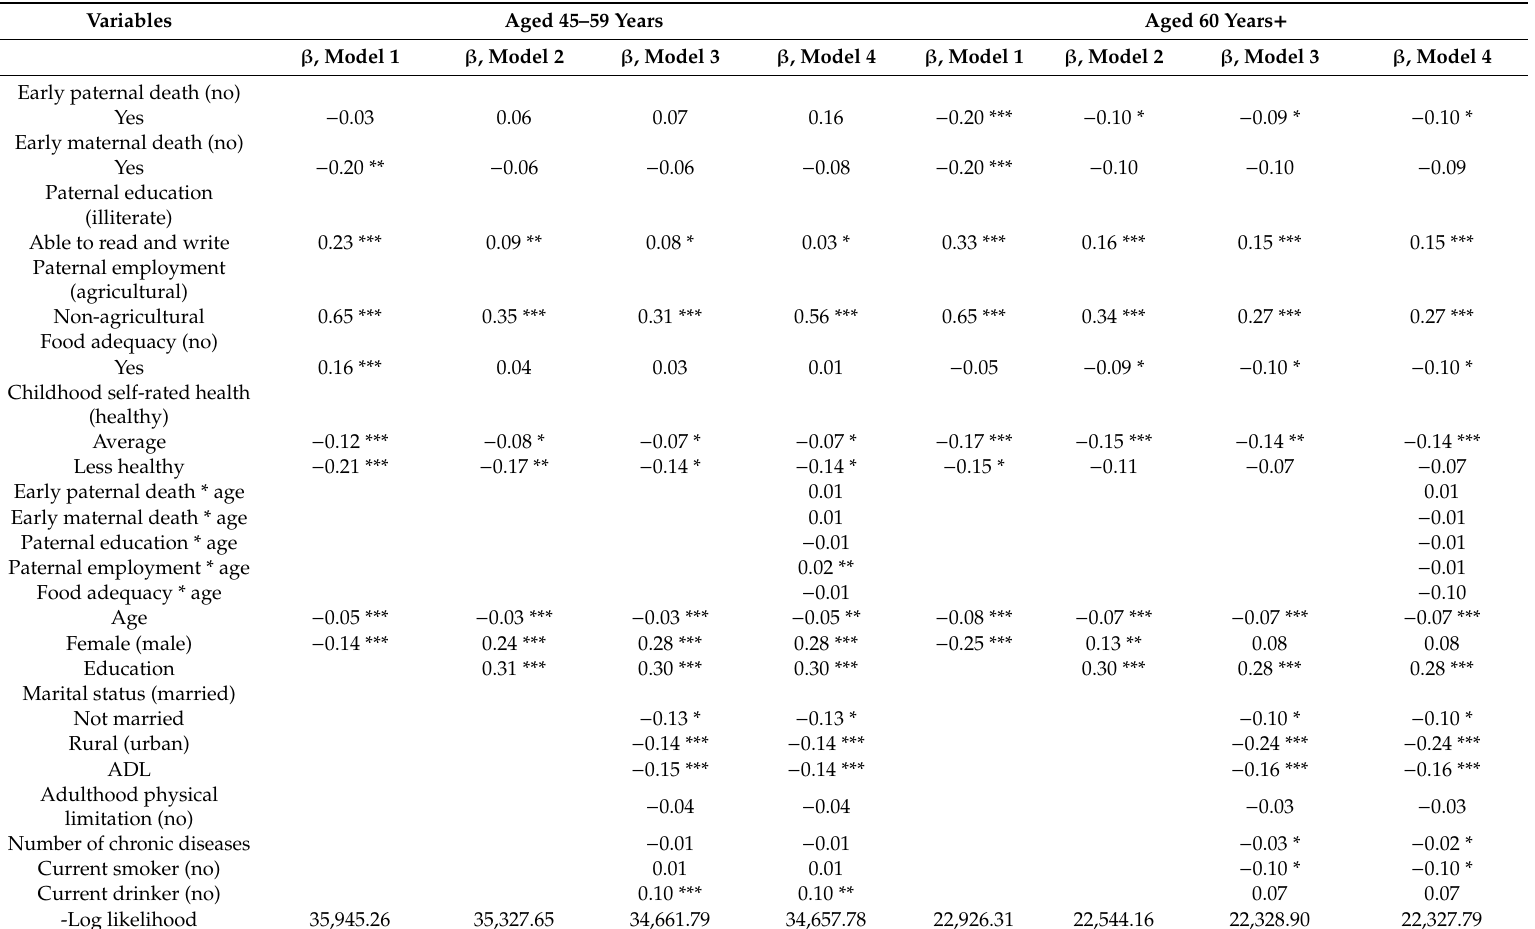
Table 4. Associations between ELCs and episodic memory scores for middle- and old-aged Chinese adults.